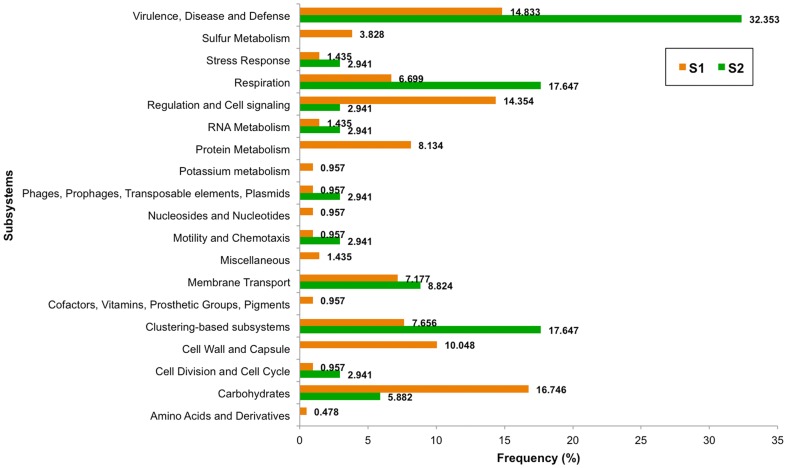
Metabolic subsystems of prokaryotic communities in S1 and S2.